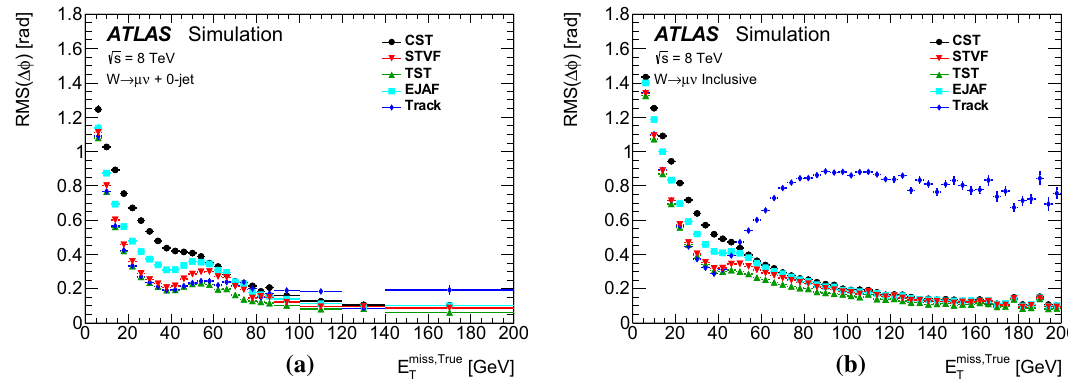
, (cid:3) E miss , True ) , labelled as RMS ((cid:12)φ) , is shown for W → μν MC simulation for the a 0-jet and b inclusive T T